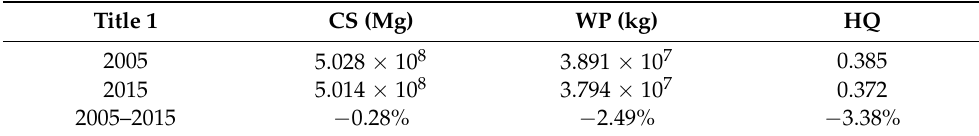
Table 3. The total amount of ESs in the YRD region in 2005 and